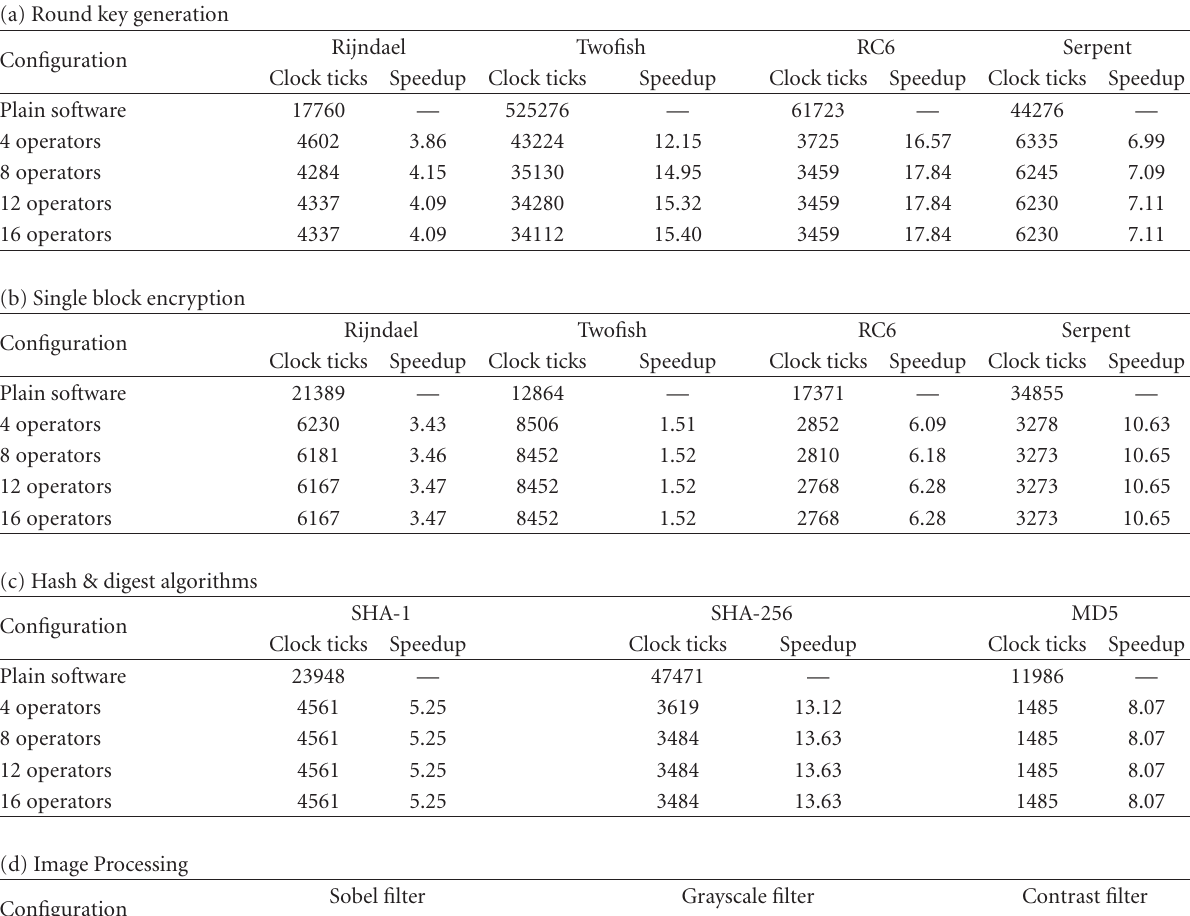
Table 2: Runtime acceleration of benchmark